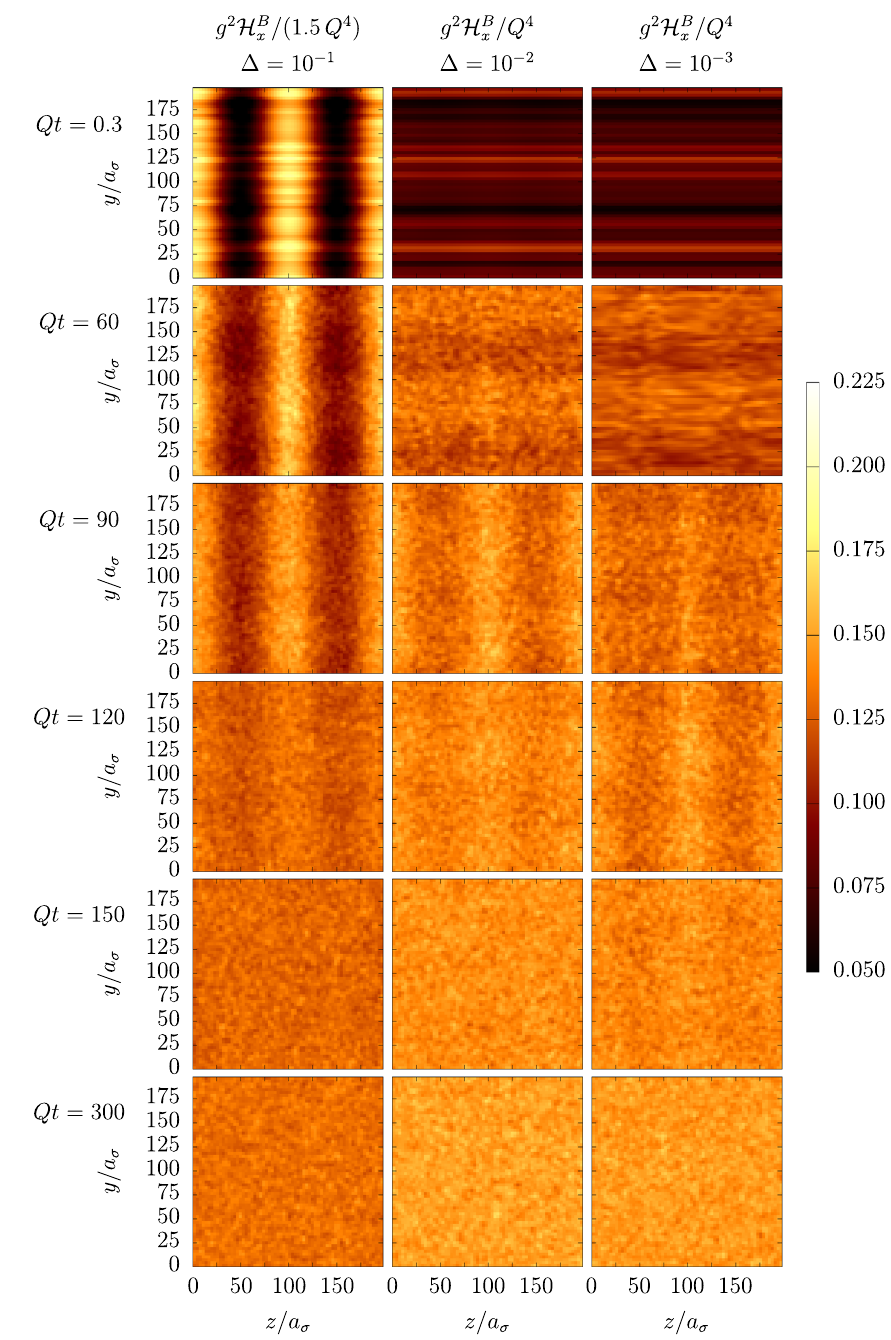
Fig. 10 Snapshots of the x -component of the chromo-magnetic energy density in the yz -plane at different times (top down: Qt = 0 . 3 , 60 , 90 , 120 , 150 , 300)